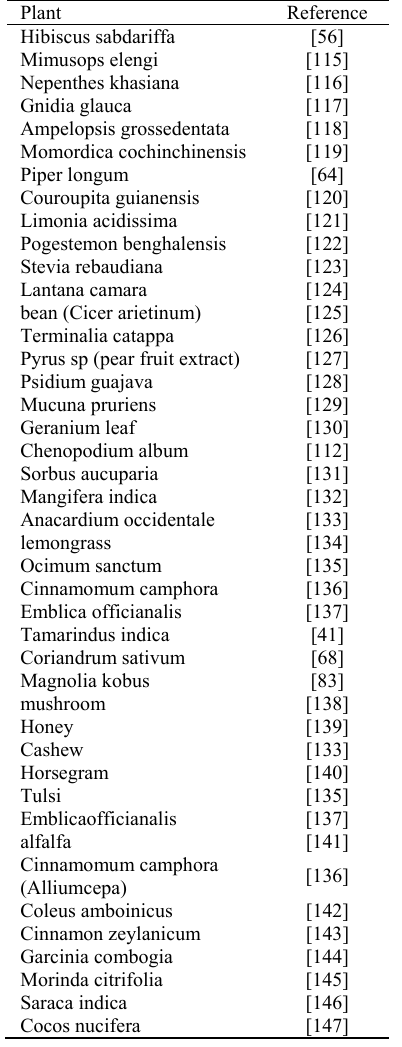
Table 1. Biosynthesis of nanoparticles using some plant extracts